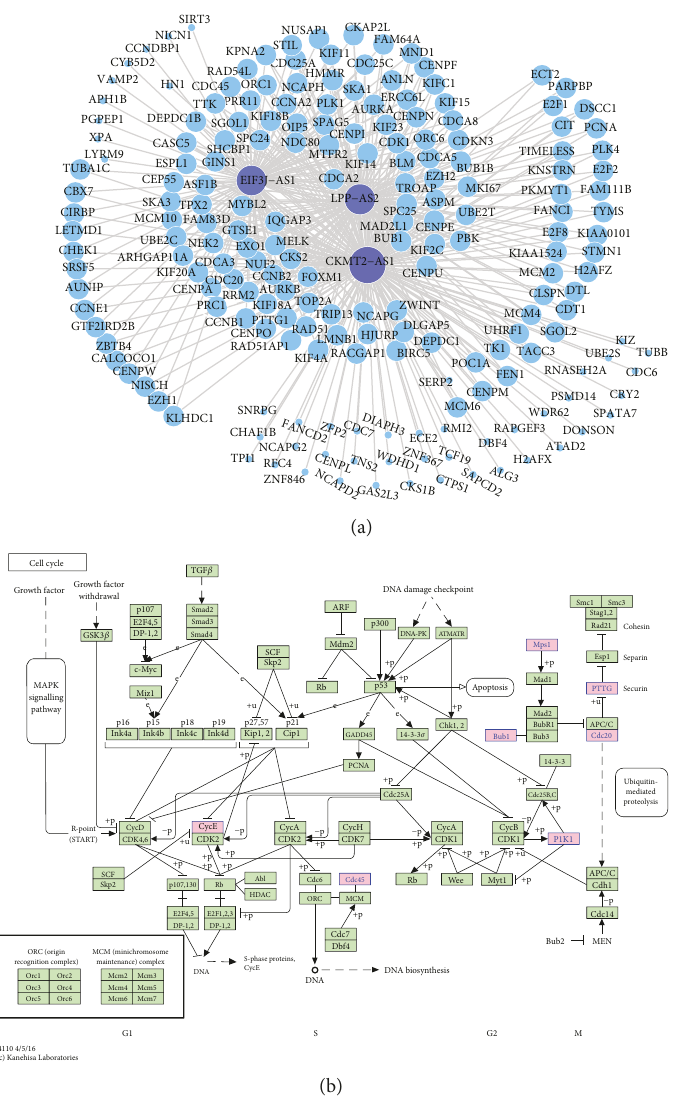
Figure 6: Coexpression network of EIF3J-AS1, LPP-AS2, and CKMT2-AS1. (a) The coexpression network was constructed for di ff erentially expressed lncRNAs and their coexpressed genes in the blue module. Node size is proportional to the number of coexpressed genes. (b) The pink background genes are the seven coexpressed genes of EIF3J-AS1 in the KEGG pathway “ cell cycle.